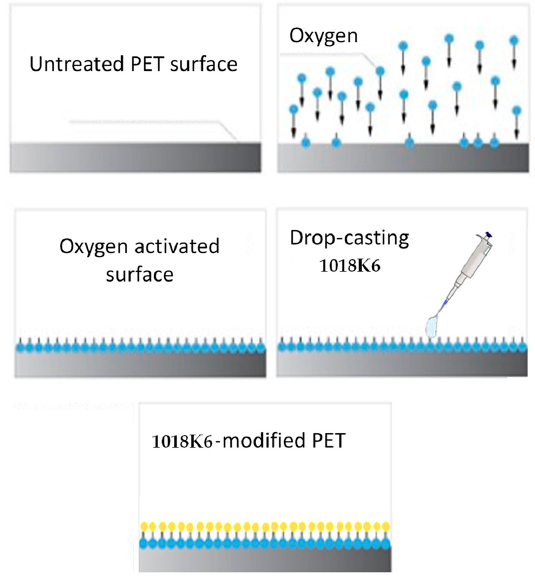
Figure 1. Process diagram for the modification of the PET surface by activation with radiofrequency cold plasma using oxygen as gas and coupling of the synthetic peptide 1018K6 with antibacterial